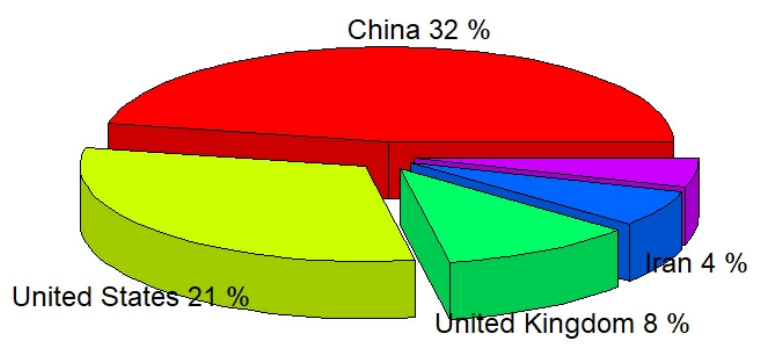
Figure 7. Proportion of top five countries from the primary studies.